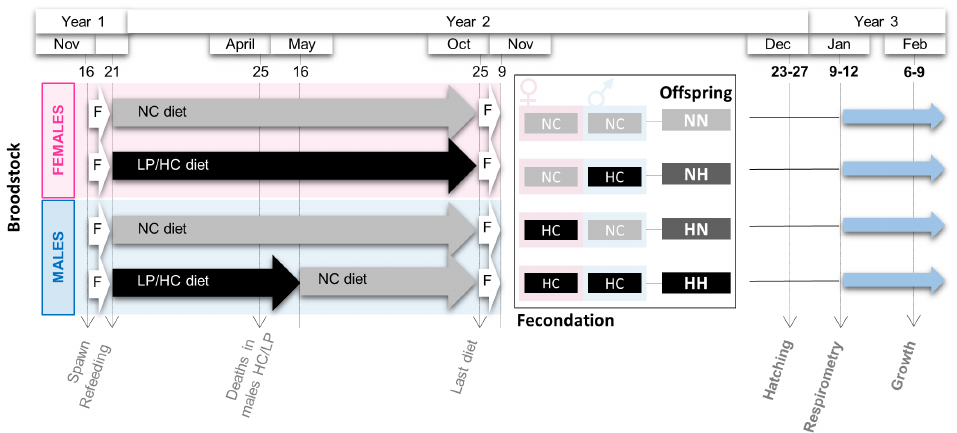
Figure 1. Experimental design. Broodstock females and males were fasted (F) after spawn from 16 Nov (November) to 21 Dec (December). Then, they were fed for one year either the NC diet (no-carbohydrate) or the HC/LP (high carbohydrate/low protein) diet (see details in Material and Methods Section). From the 25 of October (Oct) to the 9 of November, broodstock fish were fasted again. Cross-fertilizations were then carried out to obtained four groups of offspring: NN, NH, HN, and HH. Respirometry analyses and samplings were performed after hatching and just before the first feeding. Offspring were then fed for 3 weeks, and a second sampling was